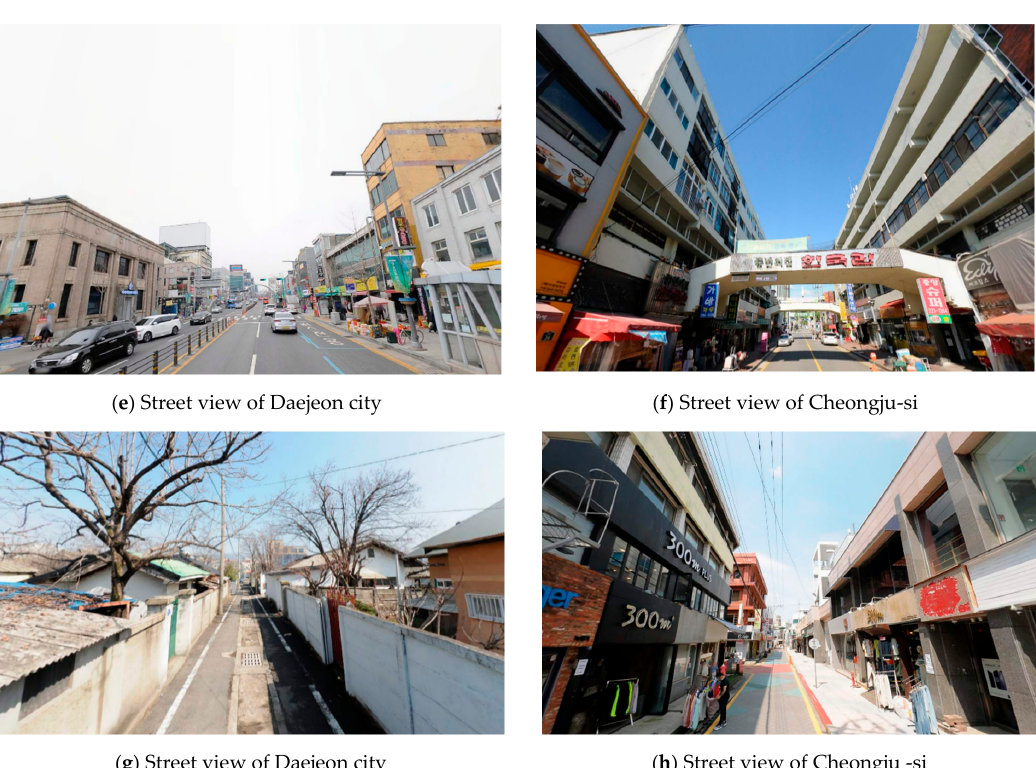
Figure 9. Review of areas with high potential for designation of AAVE zones (left Daejeon city, right Cheongju-si).